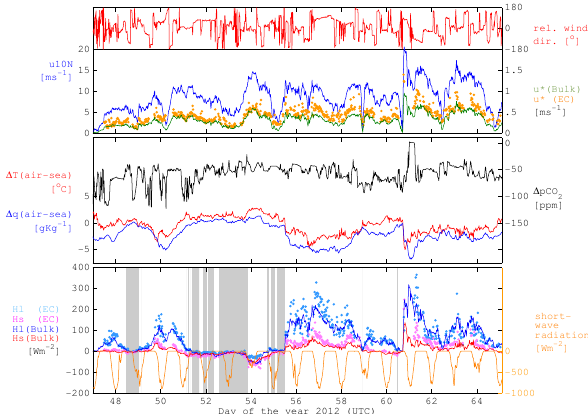
Table 2. Average CO 2 fluxes in [molm − 2 yr − 1 ] for the com- plete experiment, and for subsets (Subset 1 [ − 7Wm − 2 ≤ Hl